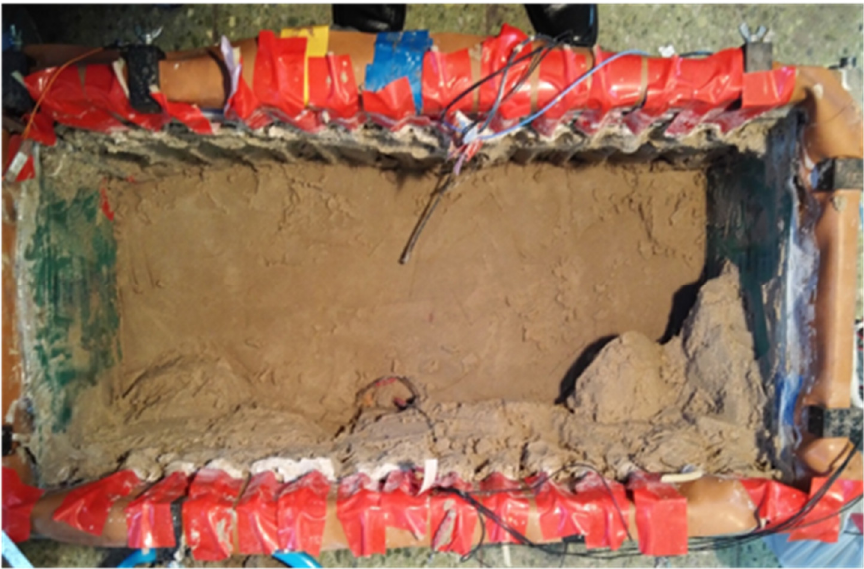
Figure 6. Spatial heterogeneity of sandy soil mineralization.